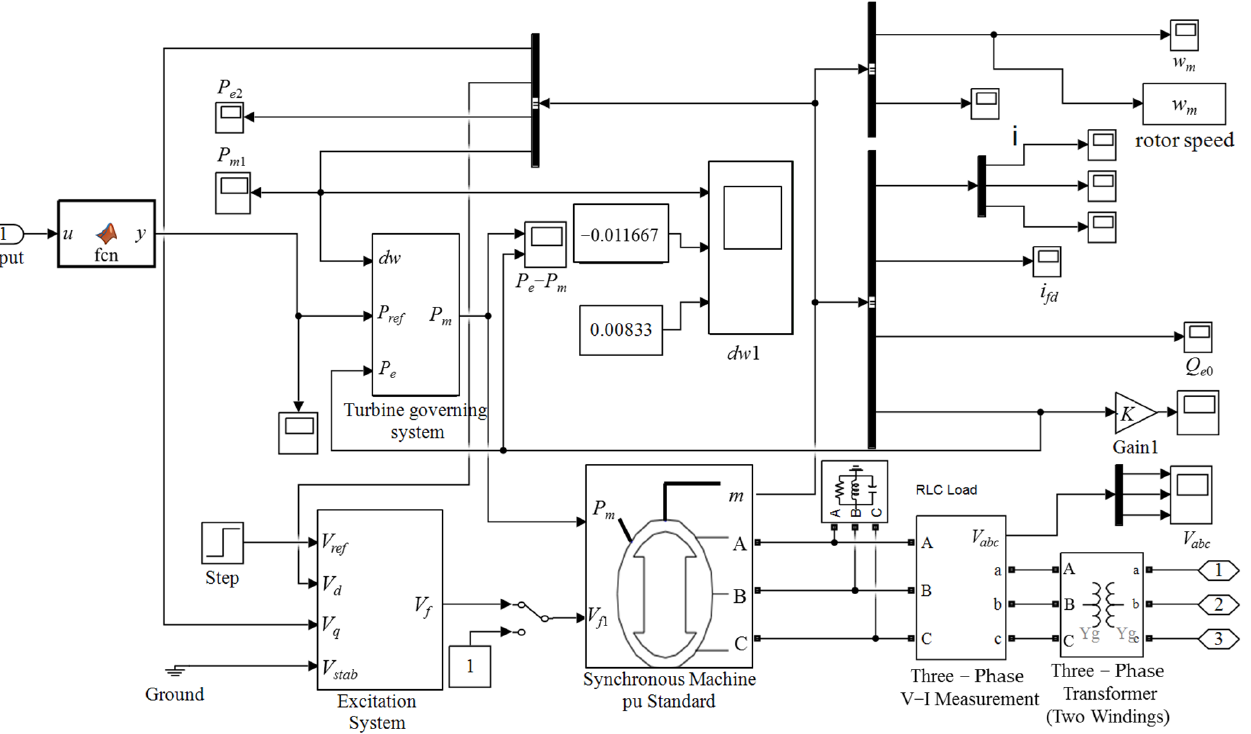
Figure 3. Block diagram of the hydropower generation system. dw , P ref , P e and P m represent the deviation of generator rotor speed, the reference power, the electrical power and the hydro-turbine output power, respectively. Vref , V d , V q , V stab and V f represent the reference voltage, the stator voltage in d -axis, the stator voltage in q -axis, the stable voltage and the field voltage of excitation system. i , i fd and Q eo represent the stator current, the field current, the reactive power.